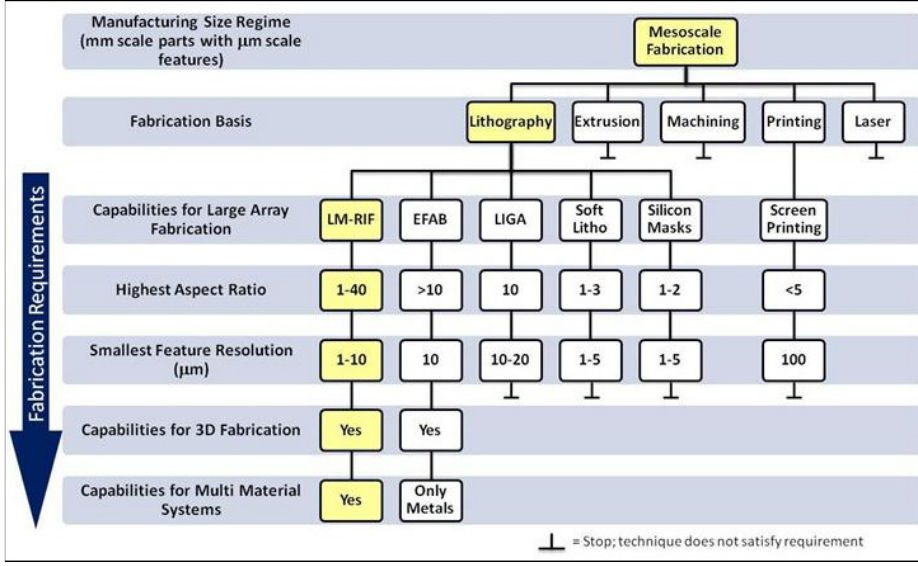
Figure 2. Hierarchy of fabrication techniques used in large array meso-scale manufacturing. Only the LM-RIF process is capable of large array fabrication of 3-D parts with high aspect ratios and small feature resolution, using multiple materials.